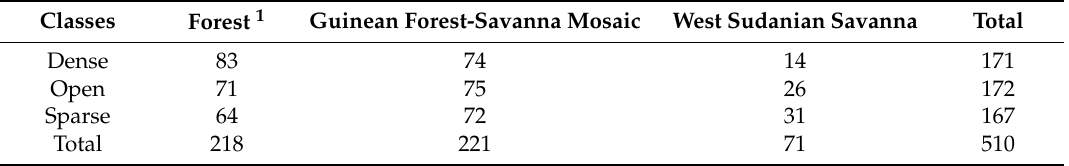
Figure 2. Examples of high resolution Google Earth images for each level of woody dominance. Table 1. Number of ground validation points used to examine the relationships between vegetation indices and different levels of woody dominance.